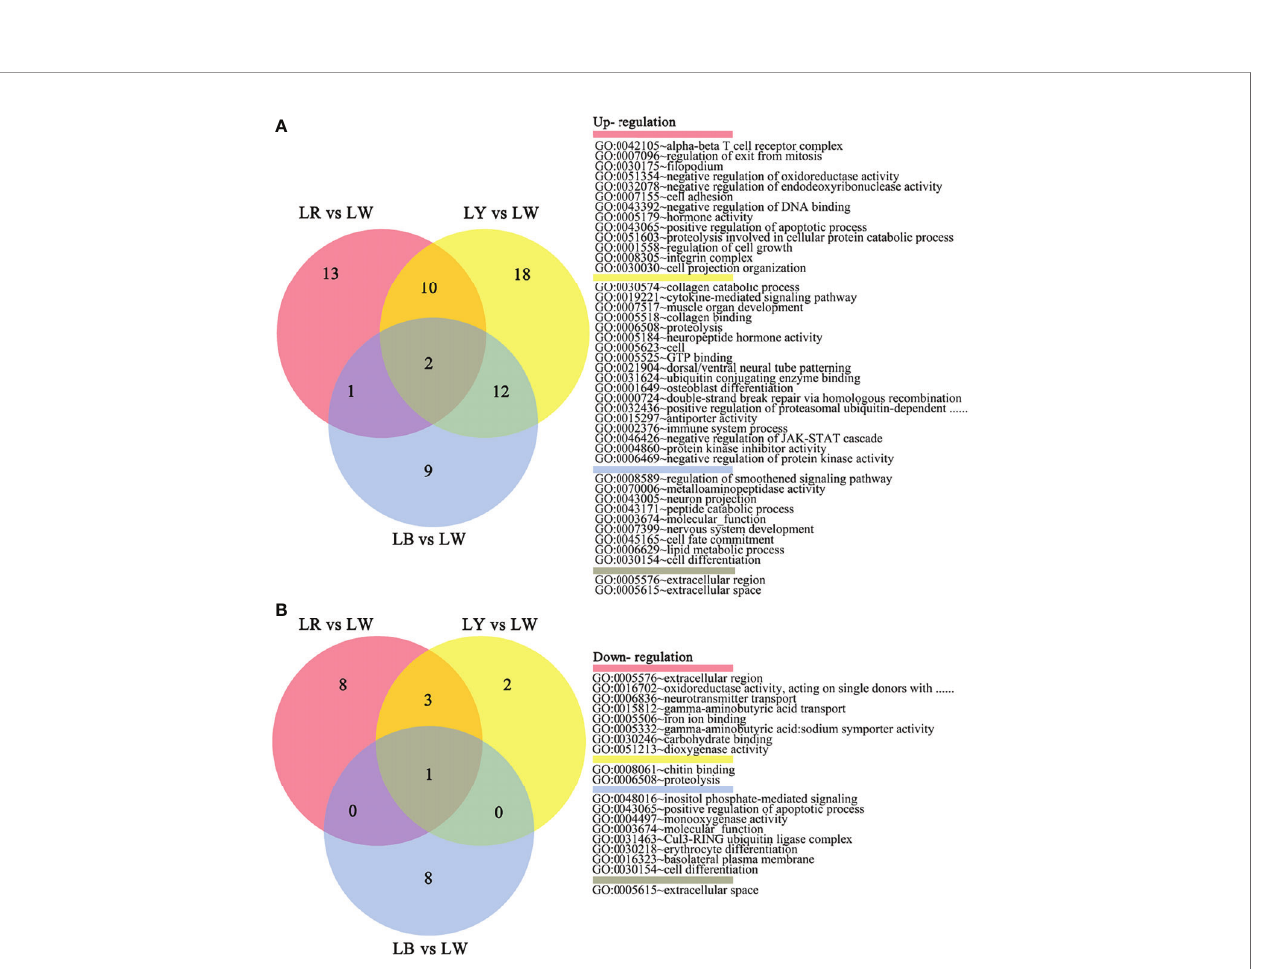
FIGURE 5 | The number of different GO terms upregulated (A) and downregulated (B) in each treatment vs. LW of GIFT tilapia juveniles. The DEGs common to different groups were represented as overlapped regions, and those unique to each group were represented as non-overlapped regions. GO, Gene Ontology; LW, full-spectrum light; DEGs, differentially expressed